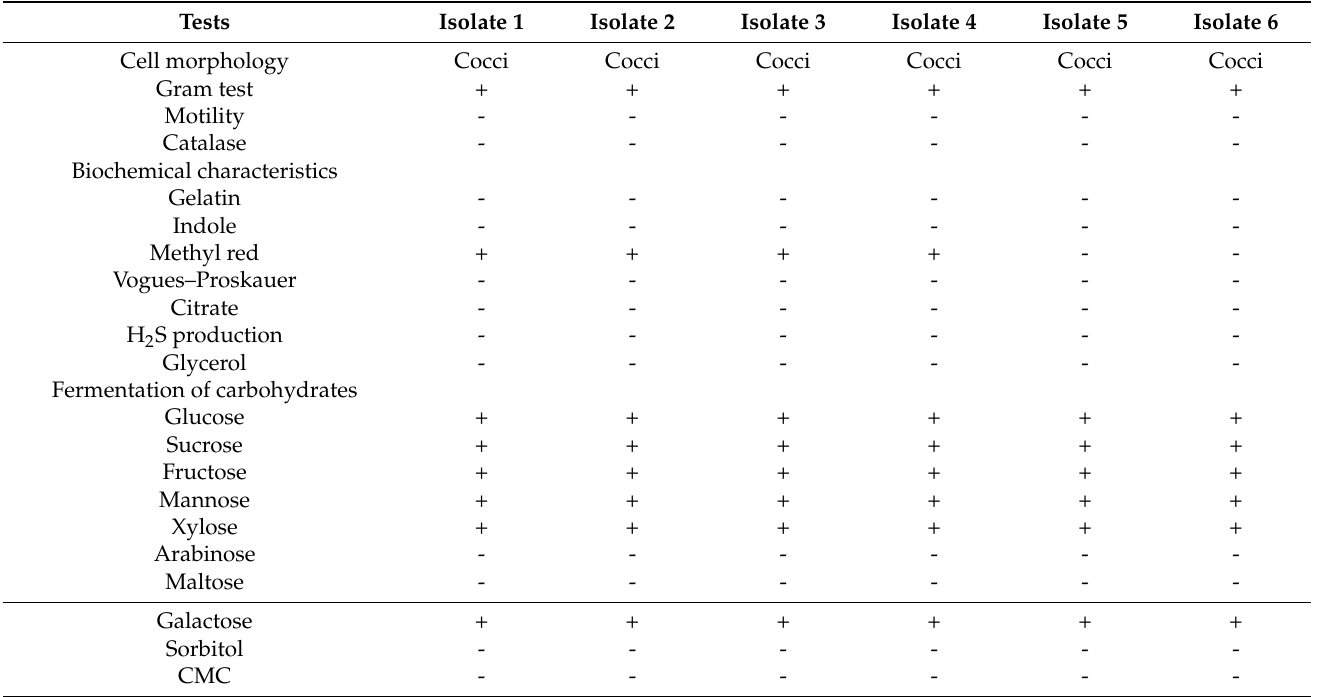
Table 1. Morphological, physiological, biochemical characteristics and sugar fermentation of isolated lactic acid